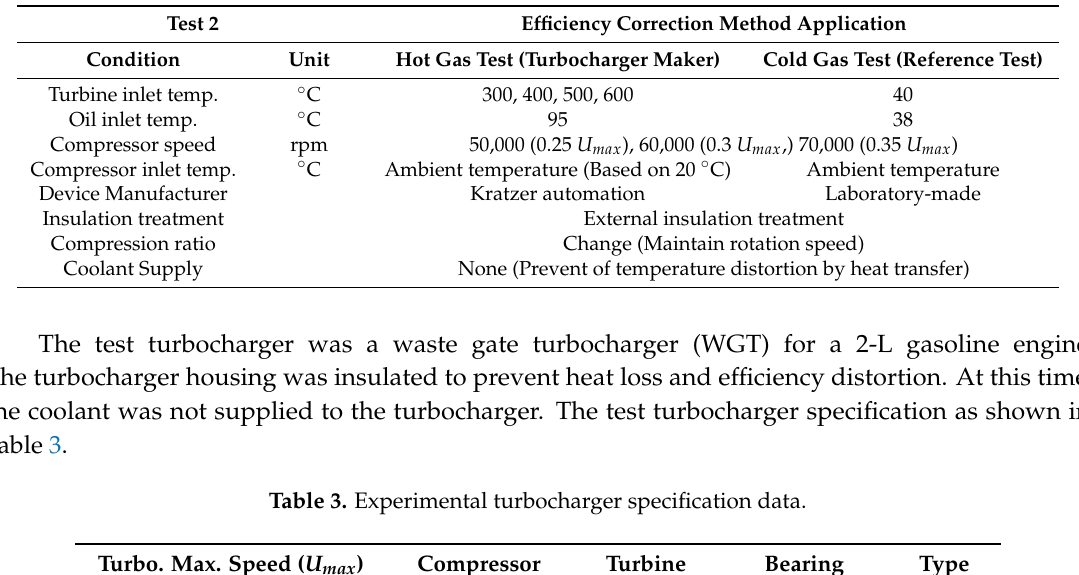
Table 2. Experimental conditions of efficiency correction method verification.